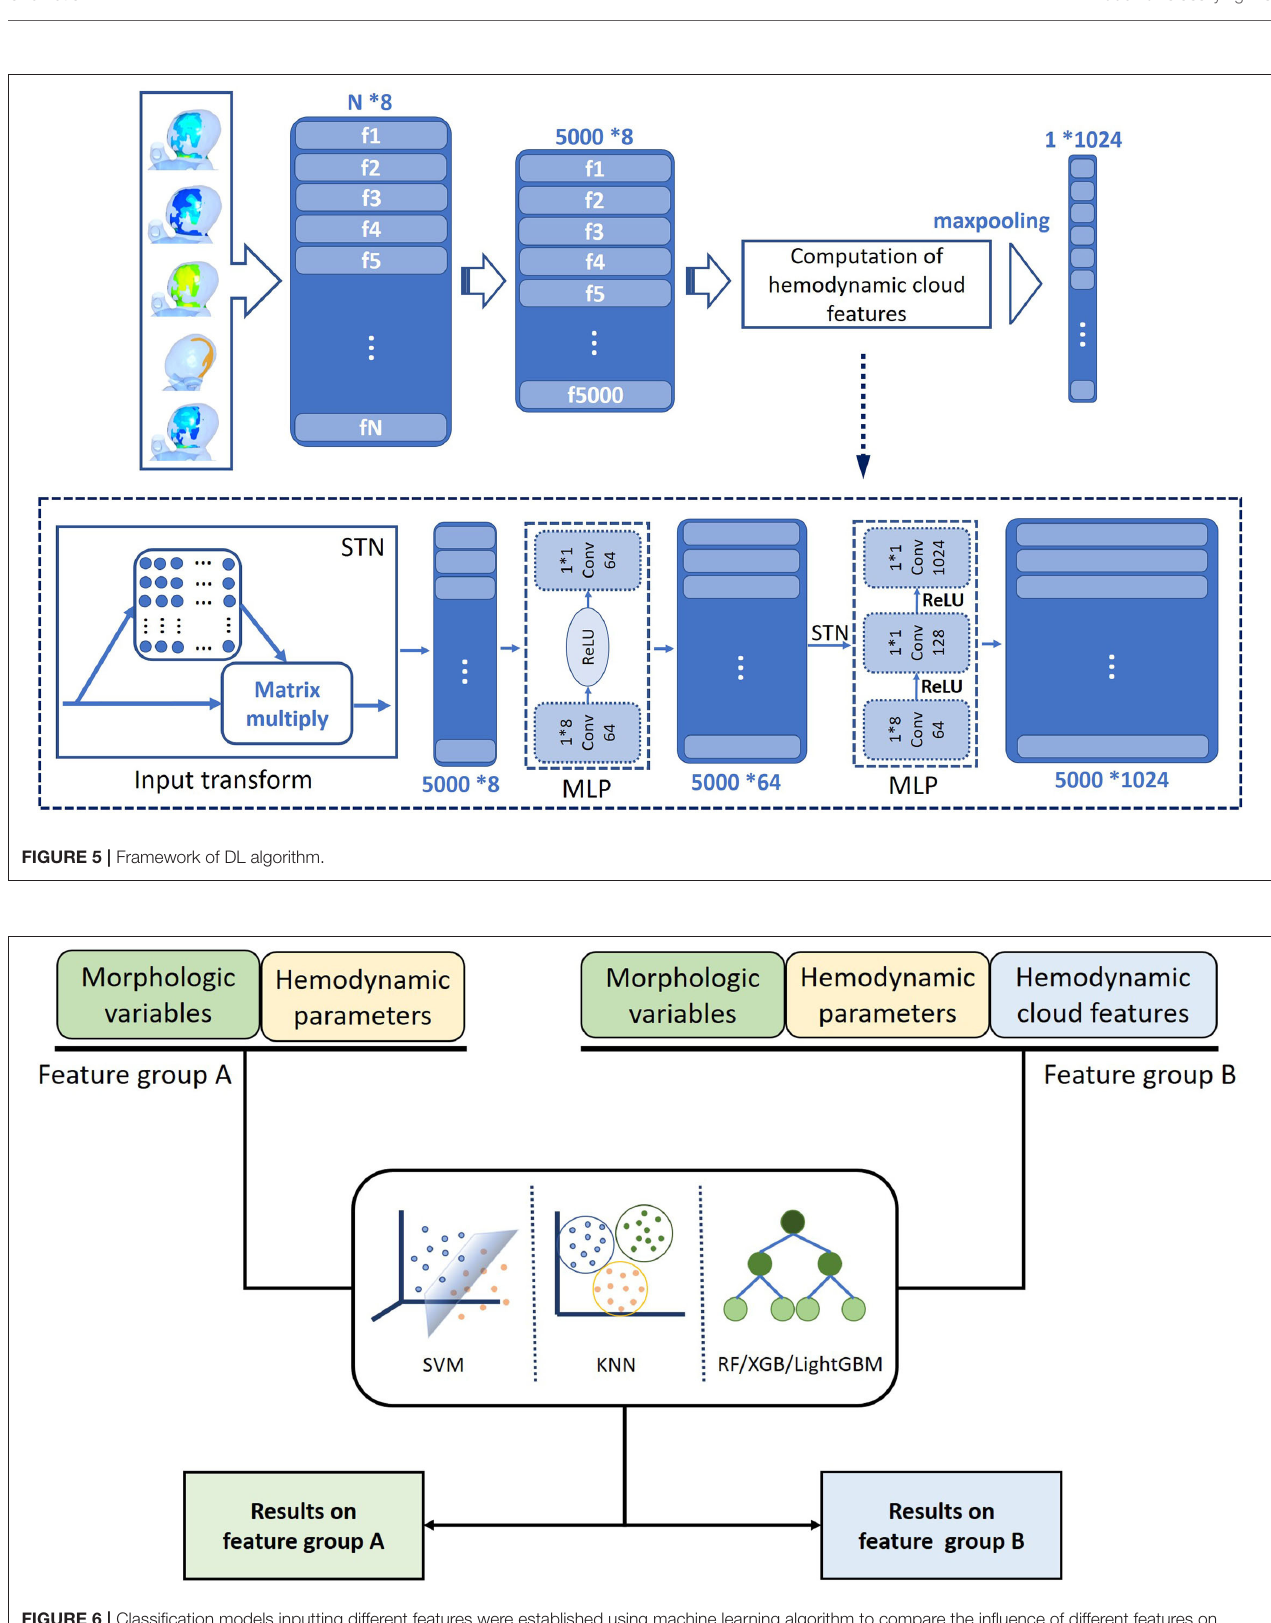
Frontiers in Neurology |